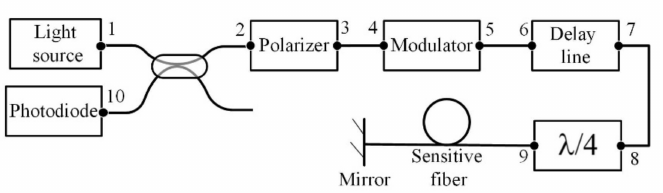
Figure 12. FOCS optical scheme in general form. The numbers 1–10 indicate the junctions between optical elements or fiber